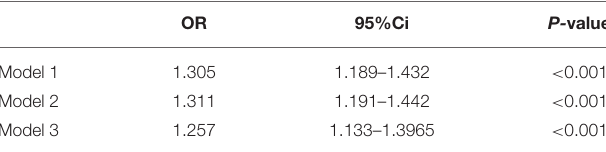
TABLE 3 | Univariate and multivariate logistic regression analysis of predictors in Model 3 for delayed cerebral ischemia after aneurysmal subarachnoid